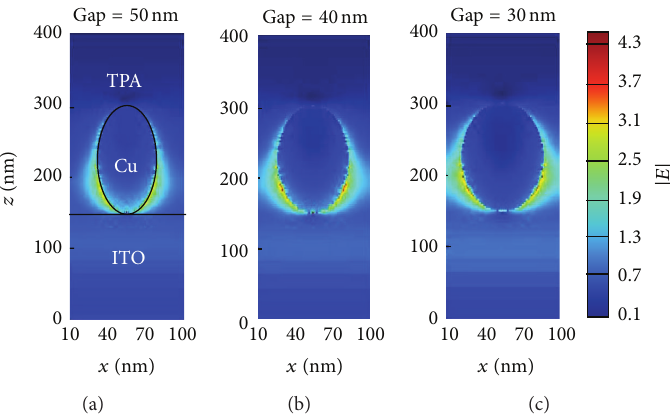
Figure 7: (a), (b), and (c) are the electric field distributions of the 𝑥 - 𝑧 plane for different gap